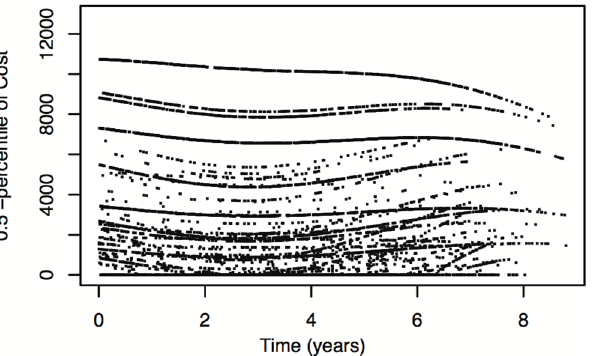
Fig 5. Estimated unconditional median Cost vs. time. Estimated unconditional median Cost vs. time, for all baseline covariate values.